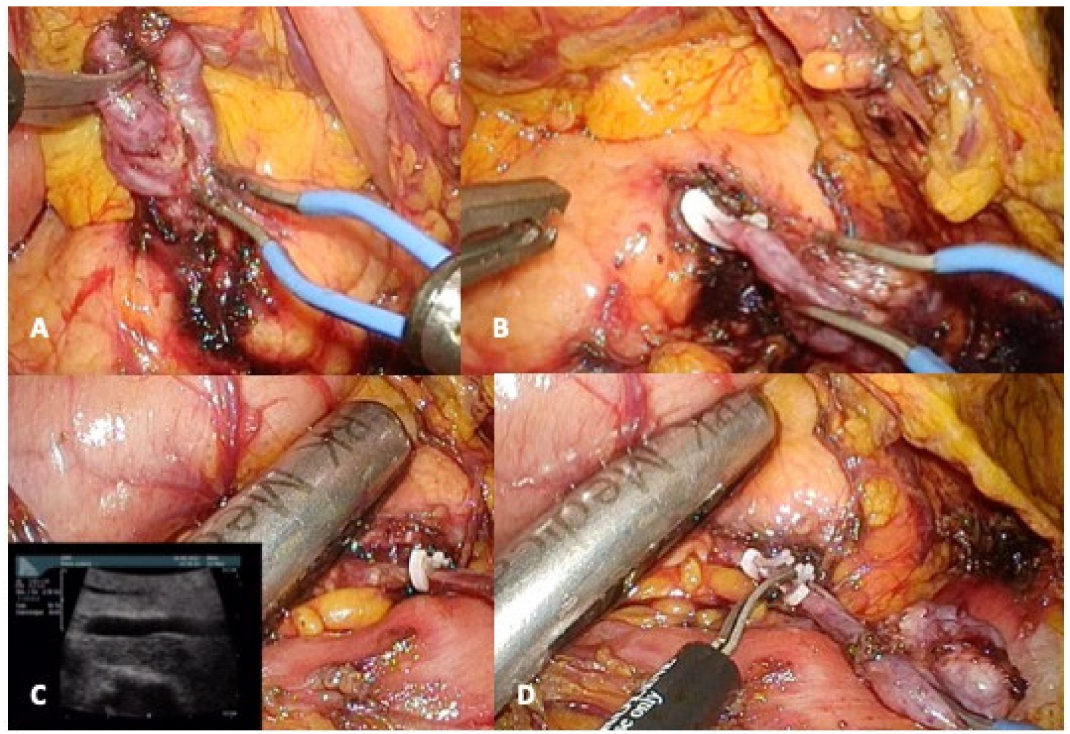
Figure 2. Laparoscopic enucleation for intraductal papillary mucinous neoplasms (IPMN). ( A ) Identification of the commu- nicant branch duct; ( B ) Secured clip at the origin of the communicant branch duct; ( C ) intraoperative ultrasonographic control; ( D ) Section of the communicant branch